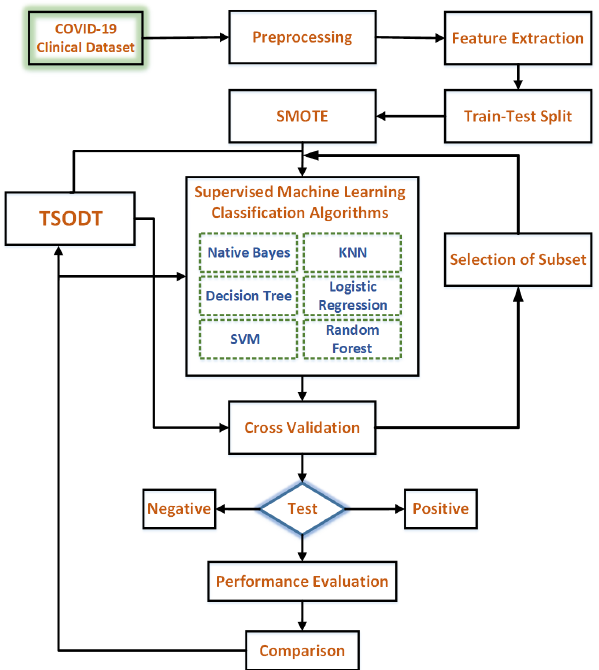
Figure 3. Complete hierarchy of the proposed